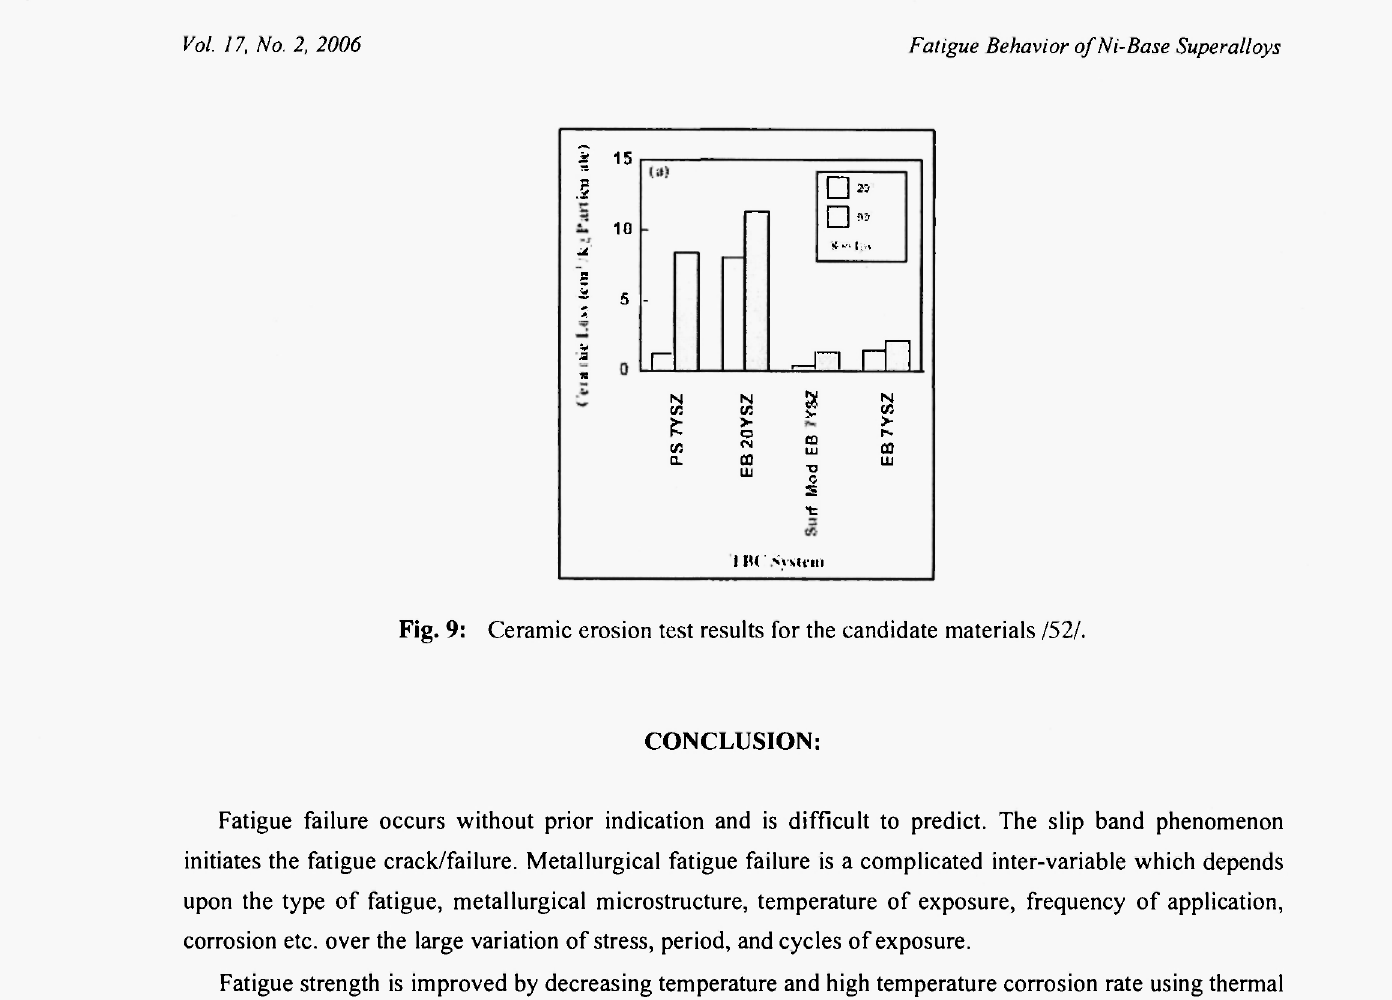
Fig. 9: Ceramic erosion test results for the candidate materials